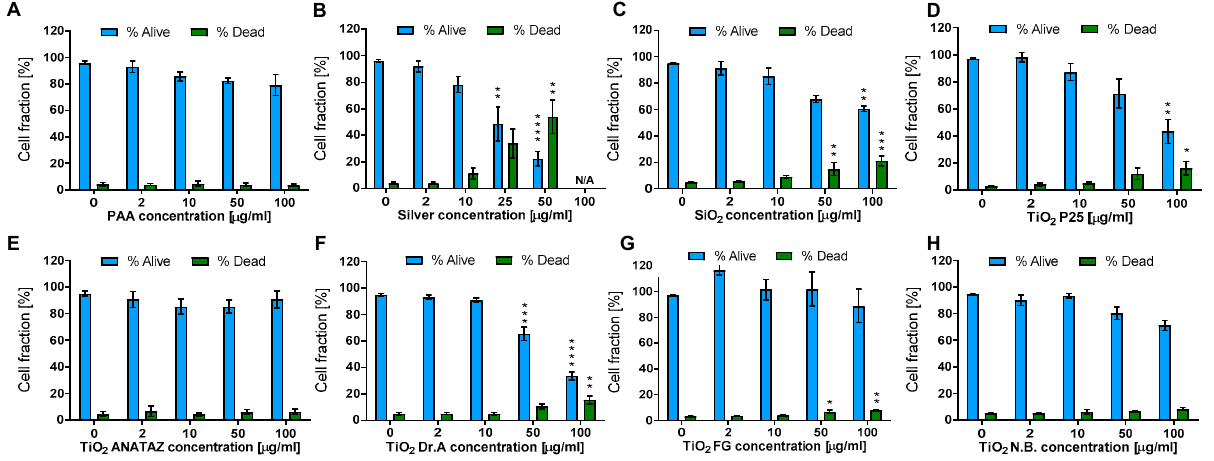
Figure 4. THP-1 viability and membrane damage following 24 h incubation with ( A ) polyacrylic acid (PAA)-coated NPs, ( B ) Ag NPs, ( C ) engineered SiO 2 NPs, ( D ) TiO 2 P25, ( E ) TiO 2 ANATAZ NPs, ( F ) TiO 2 DrA NPs, ( G ) TiO 2 food-grade (FG), and ( H ) TiO 2 N.B. NPs. The viability was determined with Hoechst/PI differential staining. Please note that lower concentrations were used for silver NPs. Mean and standard error are shown for three independent experiments. Statistical significance is displayed as follows: ns ( p > 0.05); * p ≤ 0.05; ** p ≤ 0.01; *** p ≤ 0.001, **** p ≤ 0.0001.